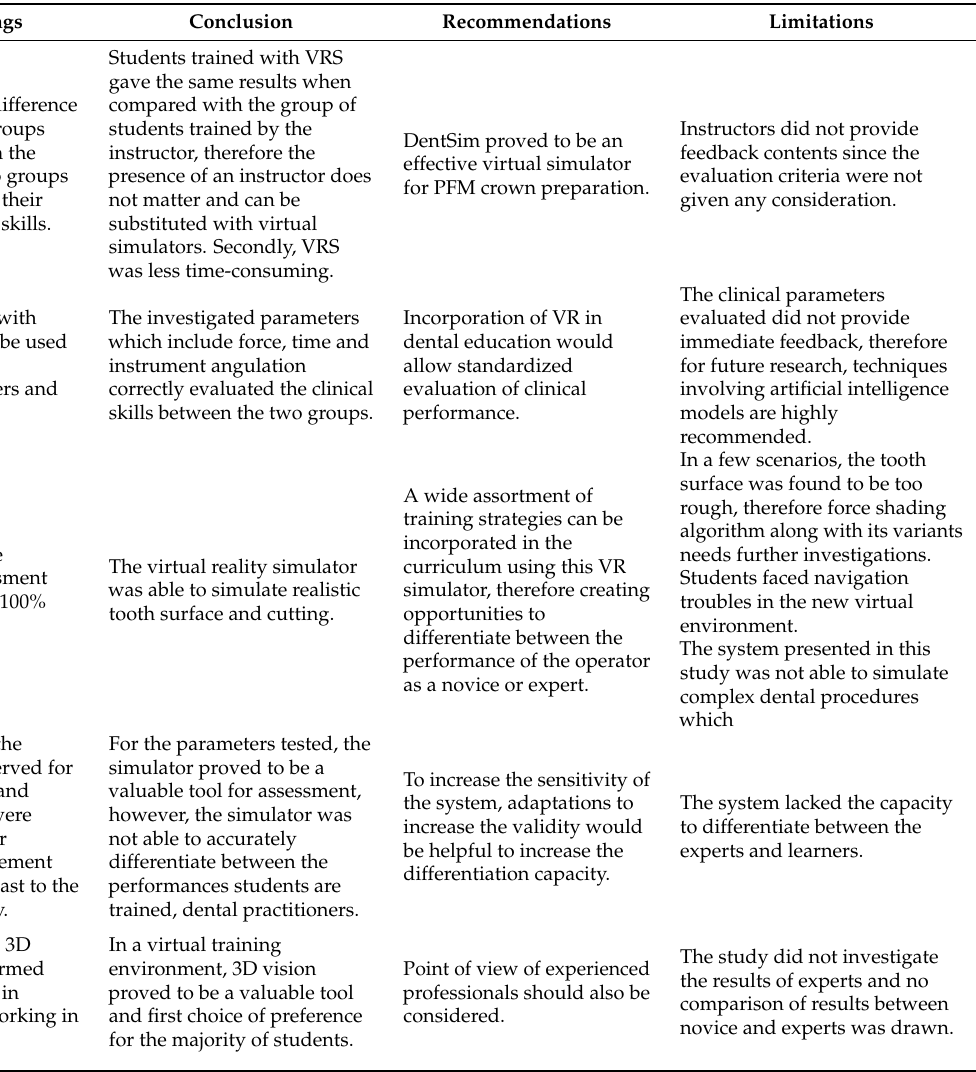
Table 5. Application of virtual reality simulation (VRS) in